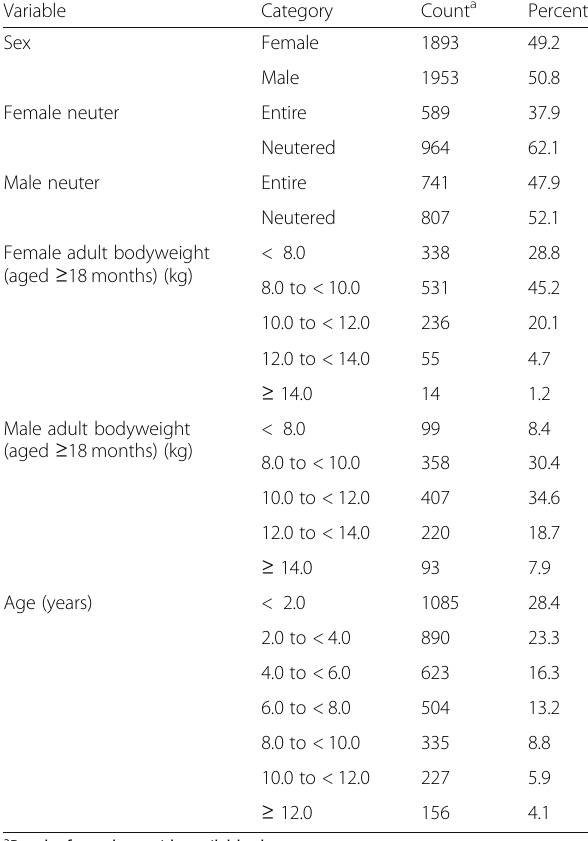
Table 1 Demography of Miniature Schnauzers under